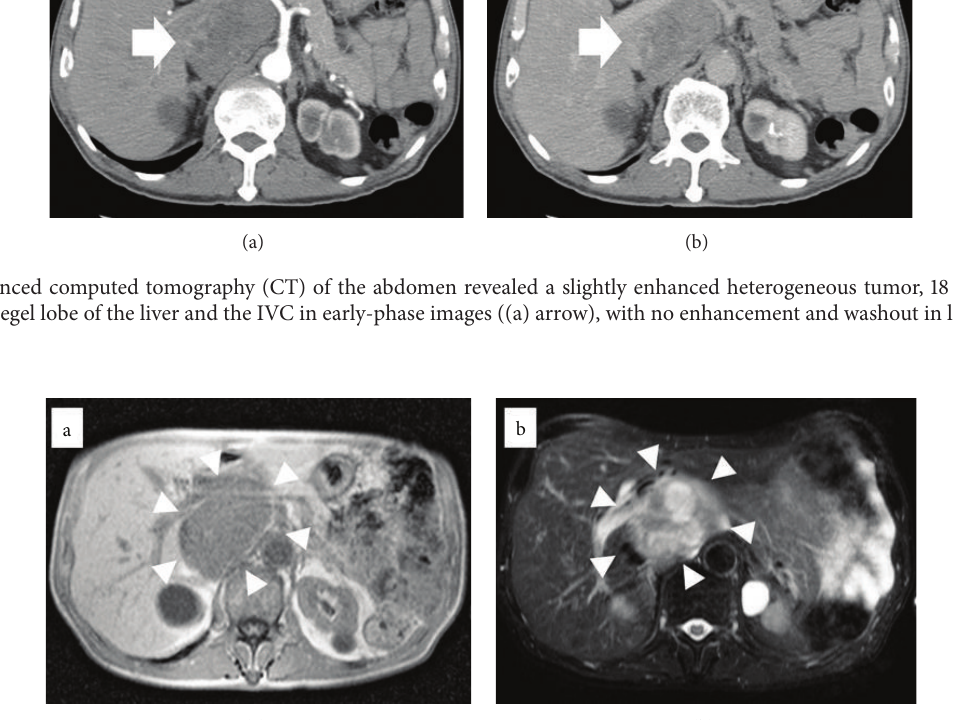
his vital signs were stable. There is nothing particularly significant in the findings of the laboratory